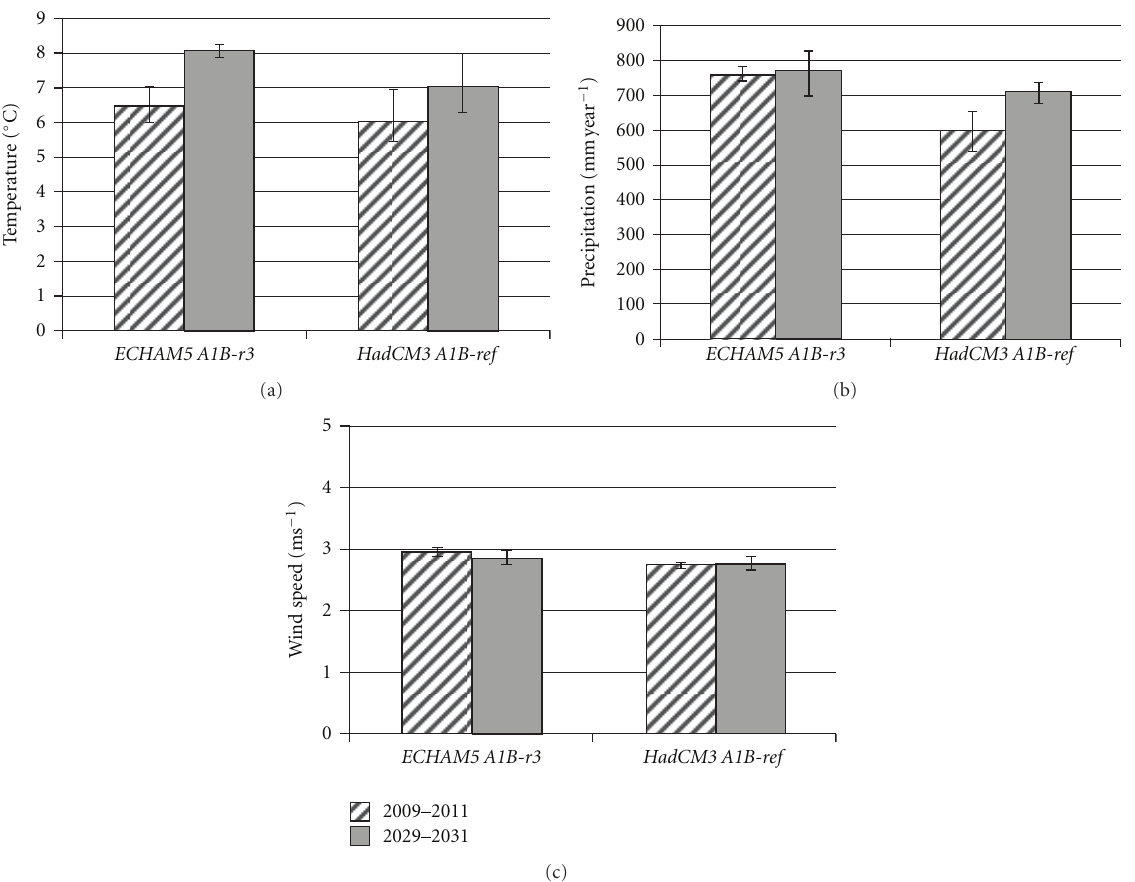
Figure 2: Three-year-averages of 2m temperature (a), precipitation (b), and wind speed (c) at Torkel Knutssonsgatan in city center of Stock- holm for the period 2009–2011 (striped) and 2029–2031 (grey). Error bars indicate maximum and minimum annual average for the 3 years.